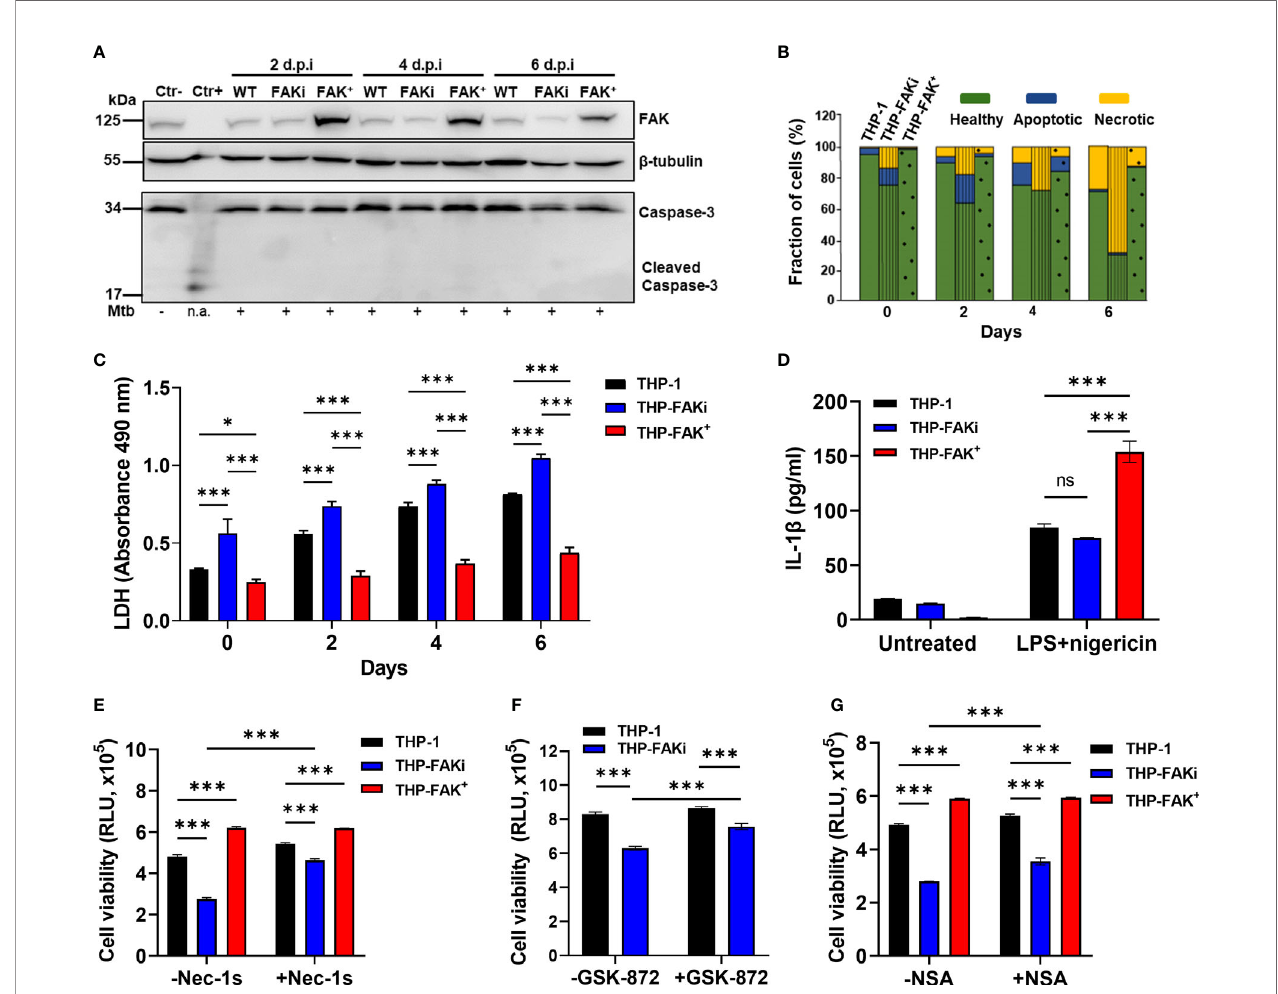
FIGURE 5 | FAK controls necroptotic cell death in macrophages during Mtb infection. (A) THP-1, THP-FAKi, and THP-FAK + macrophages were infected with Mtb at an MOI of 10, and cell lysates were prepared at the indicated days post-infection (d.p.i.). Total and cleaved caspase 3, and total FAK protein levels were analyzed by western blotting. Non-infected THP-1 cell lysates were used as a negative control for caspase 3 activation, while lysates containing cleaved caspase-3 (#9663, Cell Signaling Technologies) were used as a positive control. b -tubulin was used as loading control. (B) THP-1, THP-FAKi, and THP-FAK + macrophages were infected as in (A) and at the indicated days post-infection, cells were stained with annexin V and FVS780. Stained cells were analyzed by fl ow cytometry to quantify the percentage of healthy, apoptotic, and necrotic cells as described in the Methods. (C) THP-1, THP-FAKi, and THP-FAK + macrophages were infected with Mtb at an MOI of 10, and lactate dehydrogenase (LDH) released in culture supernatants were assessed using the CYQUANT LDH kit at indicated days post-infection. The amount of LDH in the supernatant is proportional to the measured absorbance at 490 nm. (D) THP-1, THP-FAKi and THP-FAK + macrophages were mock treated or pre-treated with 1 µg/ml LPS for 4 h, followed by treatment with 5 µM nigericin for 24 h Macrophage viability was assessed using the Cell Titre-Glo assay. (E – G) THP-1, THP-FAKi, and/or THP-FAK + macrophages were mock treated or pre-treated with (E) necrostatin-1s (Nec-1s, 10 µM), (F) GSK-872 (5 µM), or (G) necrosulfonamide (NSA, 10 µM) for 24 h Cells were then infected with Mtb at an MOI of 10 for 6 days, and cell viability was assessed using the Cell Titer-Glo assay. Error bars represent the mean ± SD of three independent biological replicates. * p < 0.05, *** p < 0.001, ns , non-signi fi